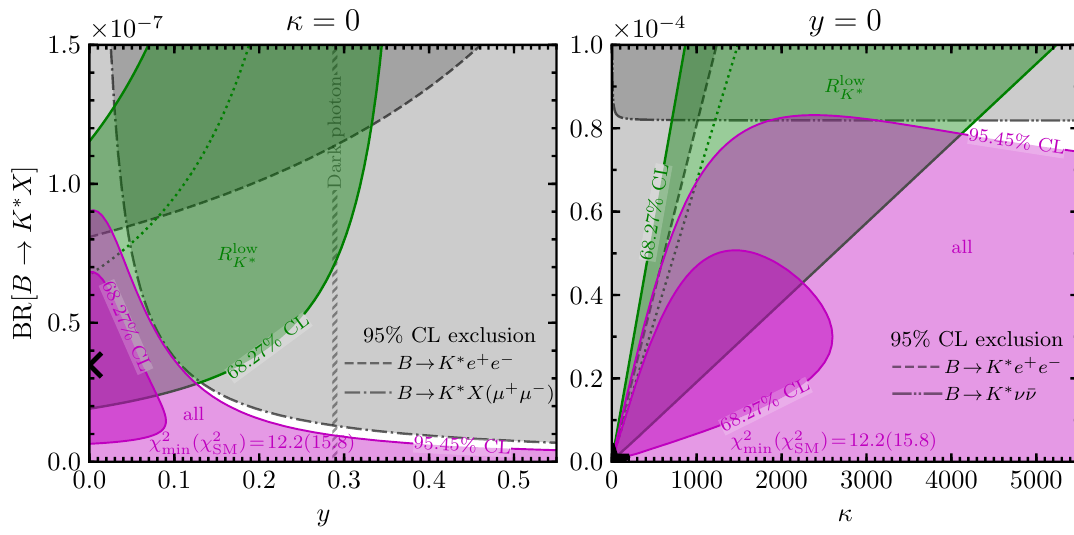
Figure 2 . Preferred regions of parameter space for a generic resonance explanation of the low- q 2 bin of R K (cid:3) . In magenta the preferred region including all constraints (see main text) and in green the preferred region from the measurement of the low- q 2 bin of R K (cid:3) alone. In grey the 95% CL exclusion regions from the measurements listed in the legend. The mass of the resonance is (cid:12)xed to 220 MeV. In the left plot the invisible branching ratio is set to zero ( (cid:20) = 0). In the right plot the branching ratio to muons is set to zero ( y = 0). The red crosses at BR( B ! K (cid:3) X ) = 3 : 5 (cid:1) 10 (cid:0) 8 and y = 0 (left), and BR( B ! K (cid:3) X ) = 3 : 5 (cid:1) 10 (cid:0) 8 and (cid:20) = 0 (right) correspond to the best-(cid:12)t